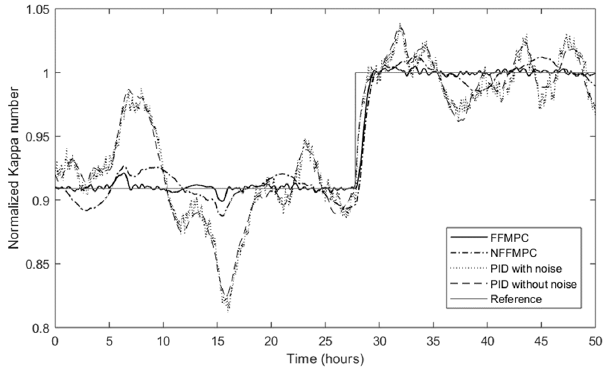
Figure 10. Responses from MPCs and PIDs under step change in the Kappa number set point.